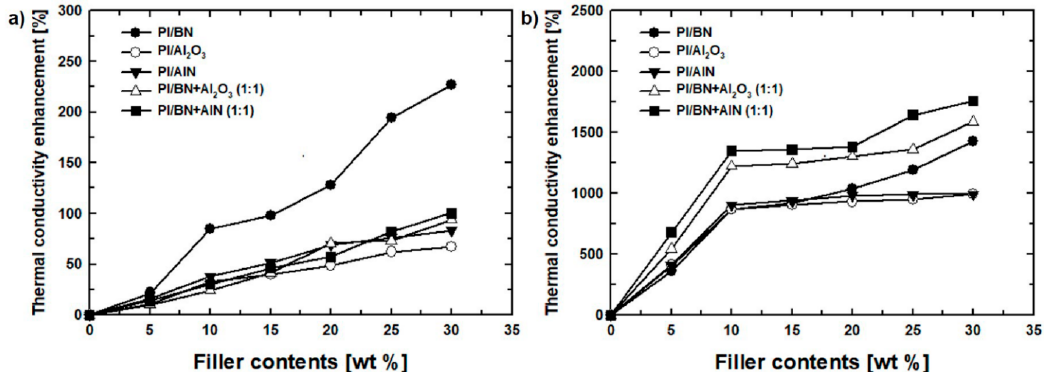
Figure 3. Thermal conductivity enhancements along the ( a ) through-plane and ( b ) in-plane directions of the composite films plotted as functions of the filler content.